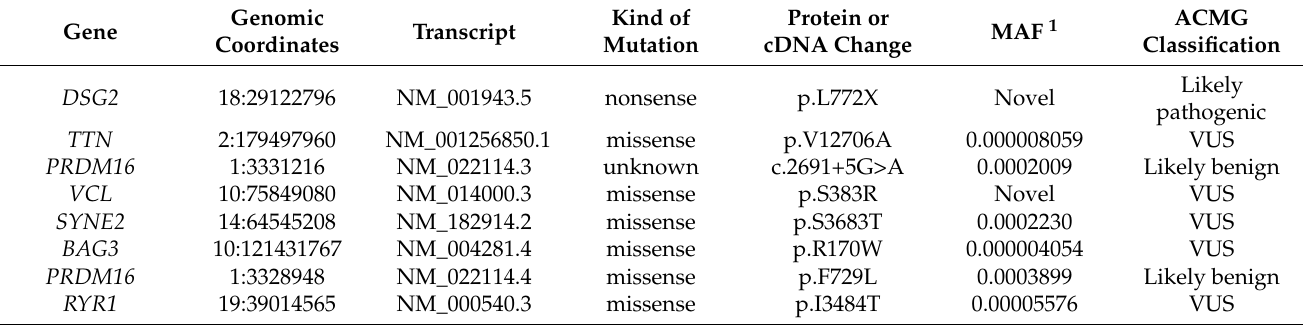
Table 2. List of rare variants (MAF < 0.001) identified in the index patient II-2 (Family B).